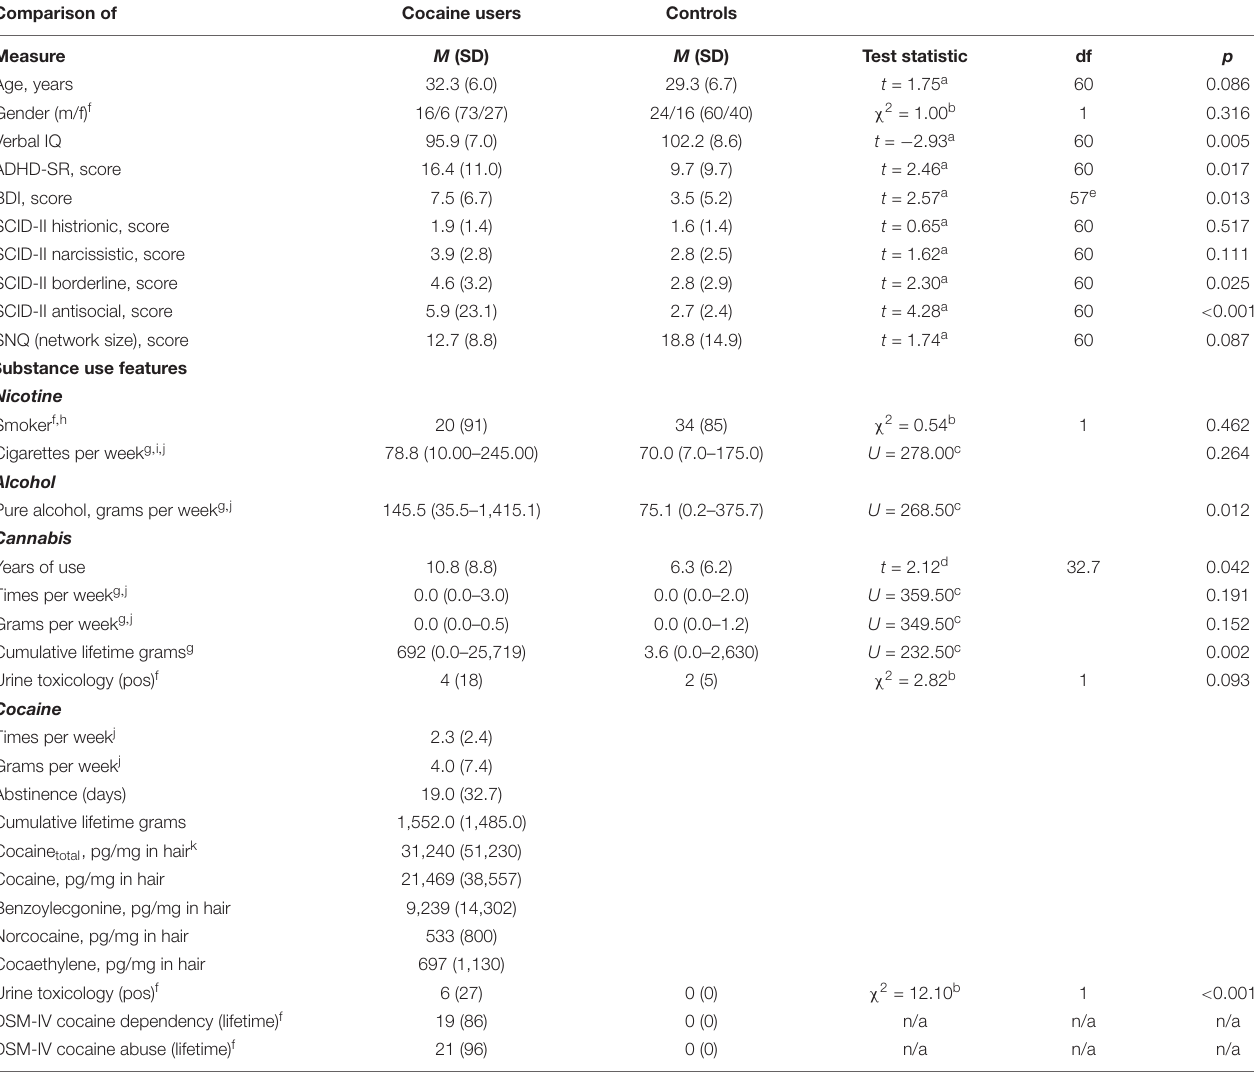
TABLE 2 | Overview of participants’ age, verbal intelligence, scores on clinical scales, and consumption features. Comparison of Cocaine